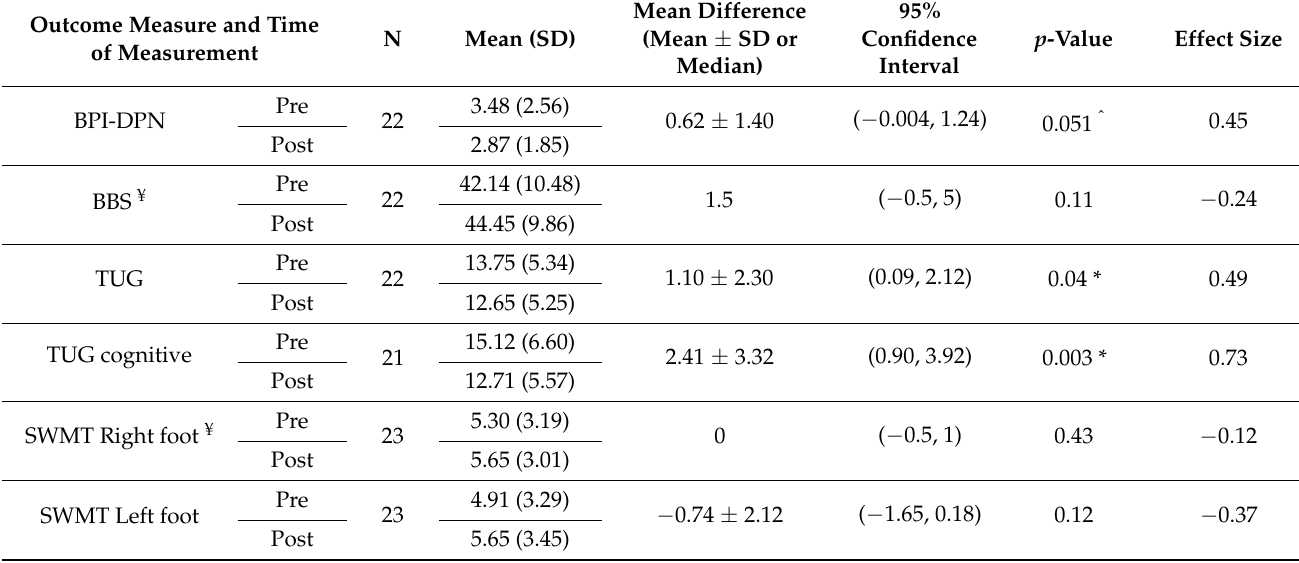
Table 2. Pain, balance, mobility, and sensation scores before and after a 4-week focal muscle vibration (FMV) intervention for all participants.